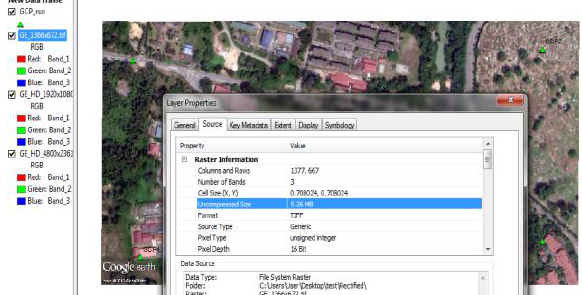
Figure 11. Metadata of the referenced photo (georeferencing) Table 2. Differences between sample